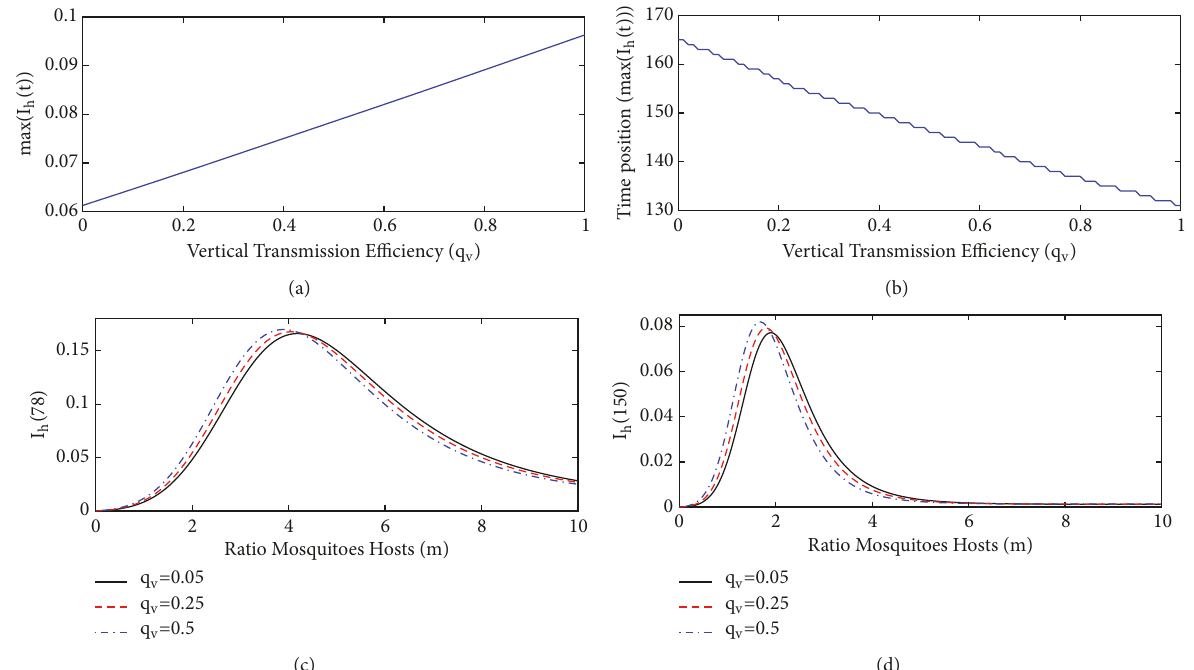
Figure 2: The left figure (a) explores effects of vertical transmission on the prevalence of the disease on hosts, where ( 𝐼 ℎ (𝑞 V ) ) is plotted at max( 𝐼 ℎ (𝑡) ) for every 𝑞 V . The right figure (b) explores how the first peak of an epidemic (max( 𝐼 ℎ (𝑡) )) varies with vertical transmission efficiency ( 𝑞 V ). The lower figures represent the dynamics of 𝐼 ℎ (𝑡) at time position (78) corresponding to day 27 (figure c) and at time position (150) corresponding to day 50 (figure d) for different values of vertical